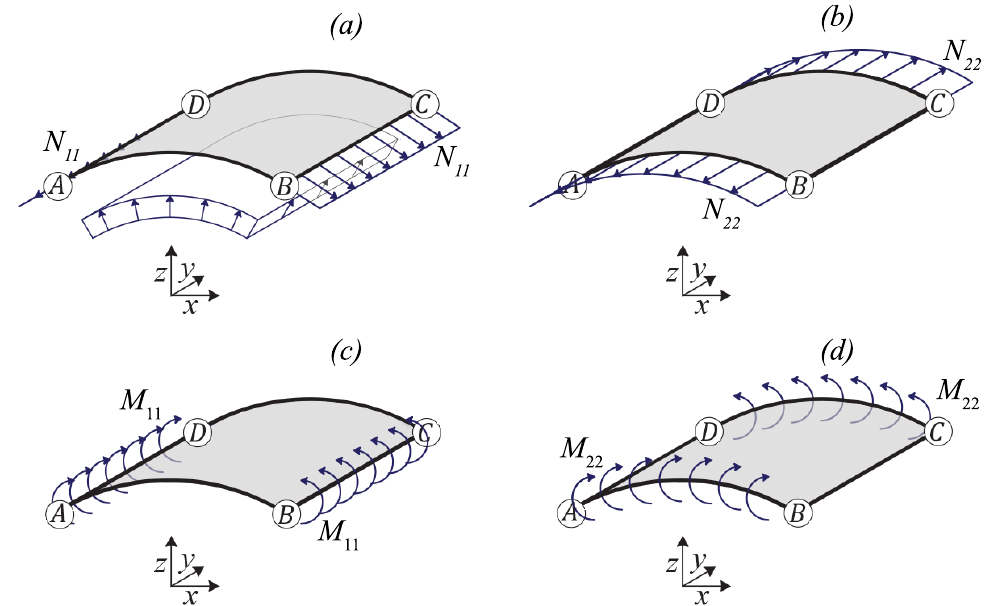
Figure 2. Internal actions in the continuum region corresponding to the REV for the four uni- form states: ( a ) N 11 membrane axial action along e 1 ( b ) N 22 membrane axial action along e 2 ( c ) M 11 bending action about e 2 ( d ) M 22 bending action about e